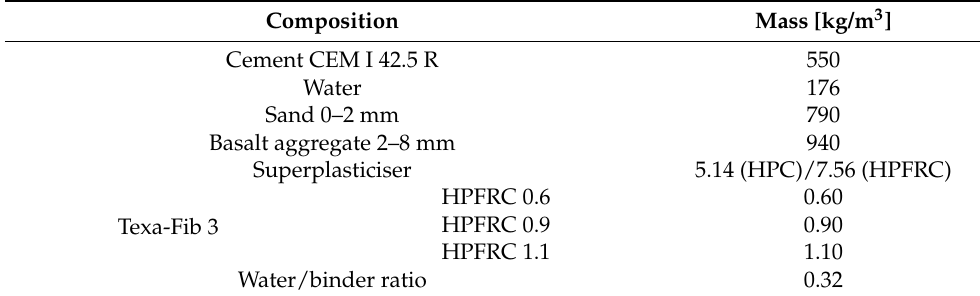
Table 1. Composition by mass of a mix.